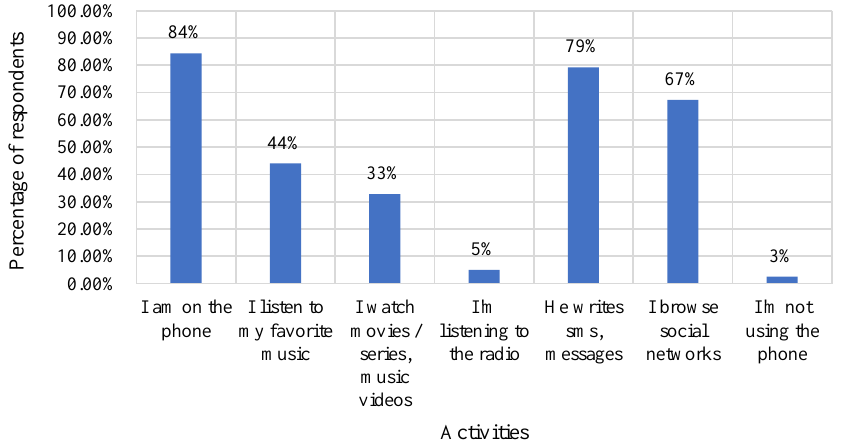
Figure 4. Characteristics of the respondents in terms of the use of a mobile phone while walking on the street or on the sidewalk.